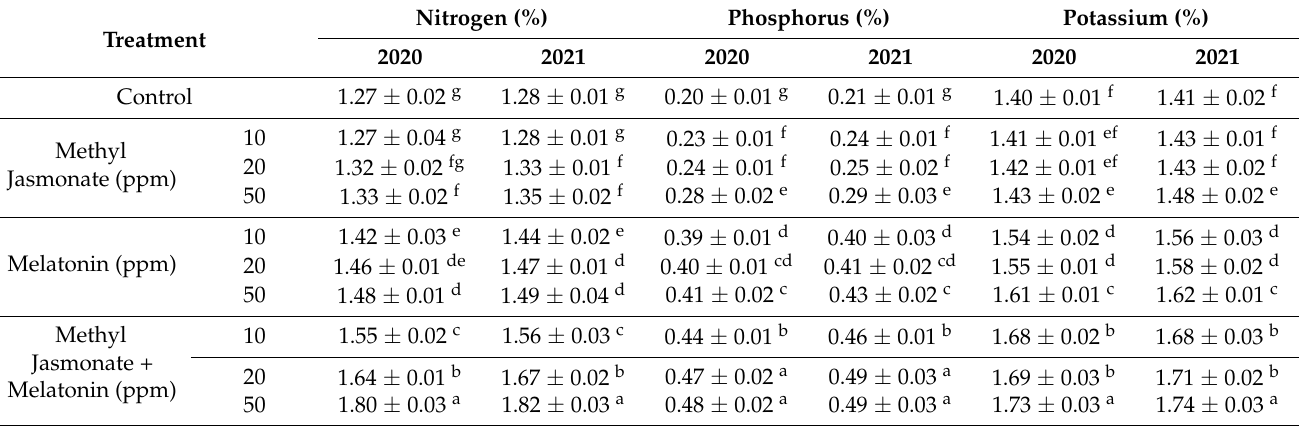
Table 1. Effects of foliar application of melatonin and/or methyl jasmonate solutions at different concentrations on nutrient contents of date palm leaves (cv. Barhi) at the harvest time